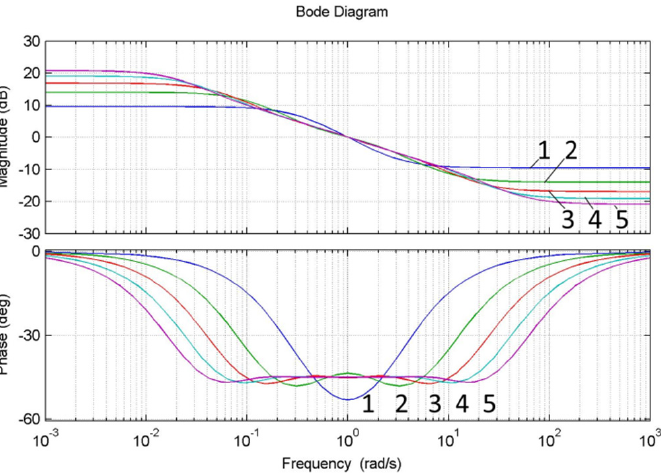
Figure 3. Transition processes of parts (13)—1, (16)—2, (23)—3, (24)—4, (25)—5.